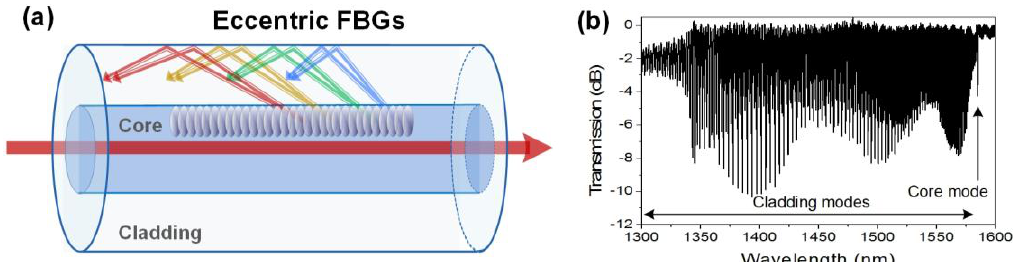
Figure 5. ( a ) Sketch of the light mode coupling in an eccentric fiber Bragg grating (EFBG); and ( b ) transmitted amplitude spectrum of a 1 cm long EFBG.